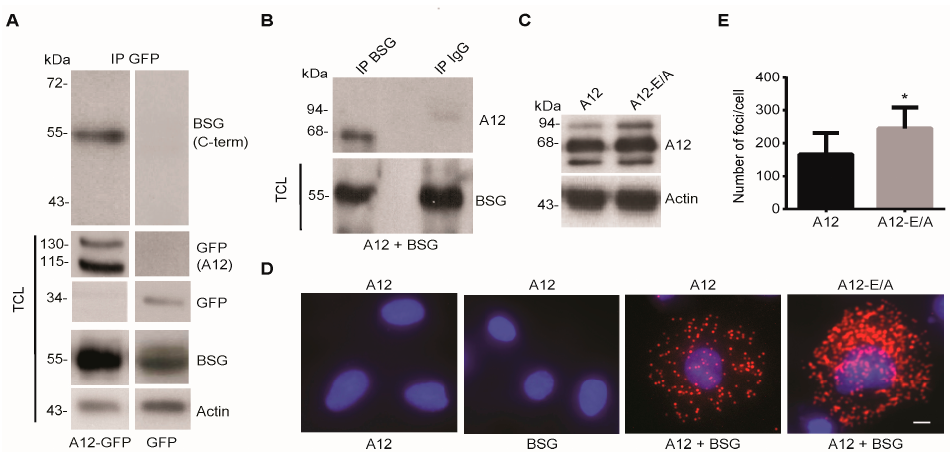
Figure 1. A disintegrin and metalloproteinase (ADAM)-12 interacts with basigin (BSG) in human cells. ( A ) 293-VnR cells were transfected with A12-GFP or GFP alone, immunoprecipitated with a polyclonal anti-GFP antibody and analyzed by Western blot, using an antibody against the C-terminal part of BSG. Total cell lysates (TCL) were tested for A12-GFP (pro and mature forms) and endogenous BSG protein expression. Actin was used as the loading control. ( B ) 293-VnR cells were co-transfected with A12 and full-length BSG, immunoprecipitated with an antibody against BSG and analyzed by Western blot, using a rabbit polyclonal antibody against A12. Immunoprecipitation with control rabbit IgG served as a negative control. ( C ) 293-VnR cells were transfected with A12 or the catalytically inactive A12-E / A mutant, together with full-length BSG and tested for A12 expression by Western blot, using actin as the loading control. ( D ) Cells from C were tested for A12-BSG co-localization by the proximity ligation assay (PLA) (red signal), using antibodies against the extracellular parts of A12 and BSG. Reactions using either of the two antibodies alone served as negative controls. Scale bar = 8 µ m. ( E ) Number of red foci were automatically counted in 50 cells from three independent experiments, using MetaMorph microscopy analysis software. The average number of foci per cells ± SEM is shown in the graph. * p < 0.05, Student’s t